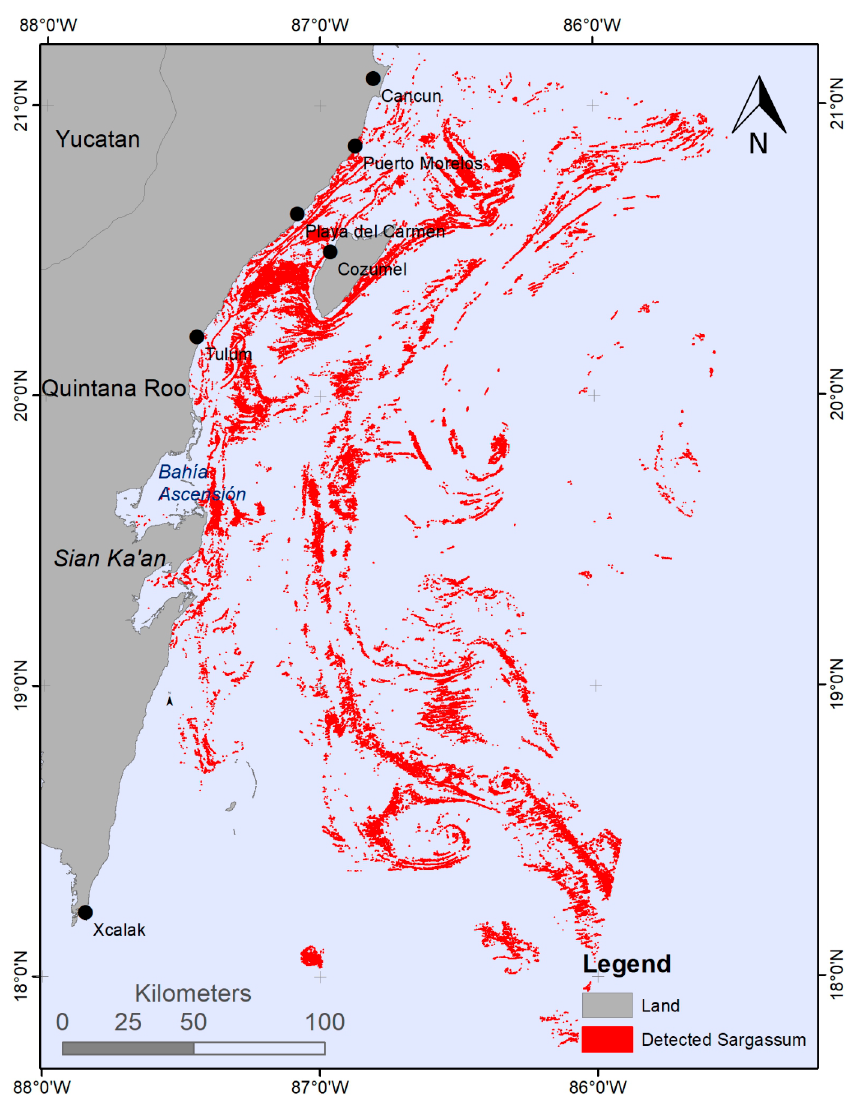
Figure 7. Sargasso cover in the open sea off the Mexican Caribbean coast in September 2018, detected with Landsat 8 imagery.